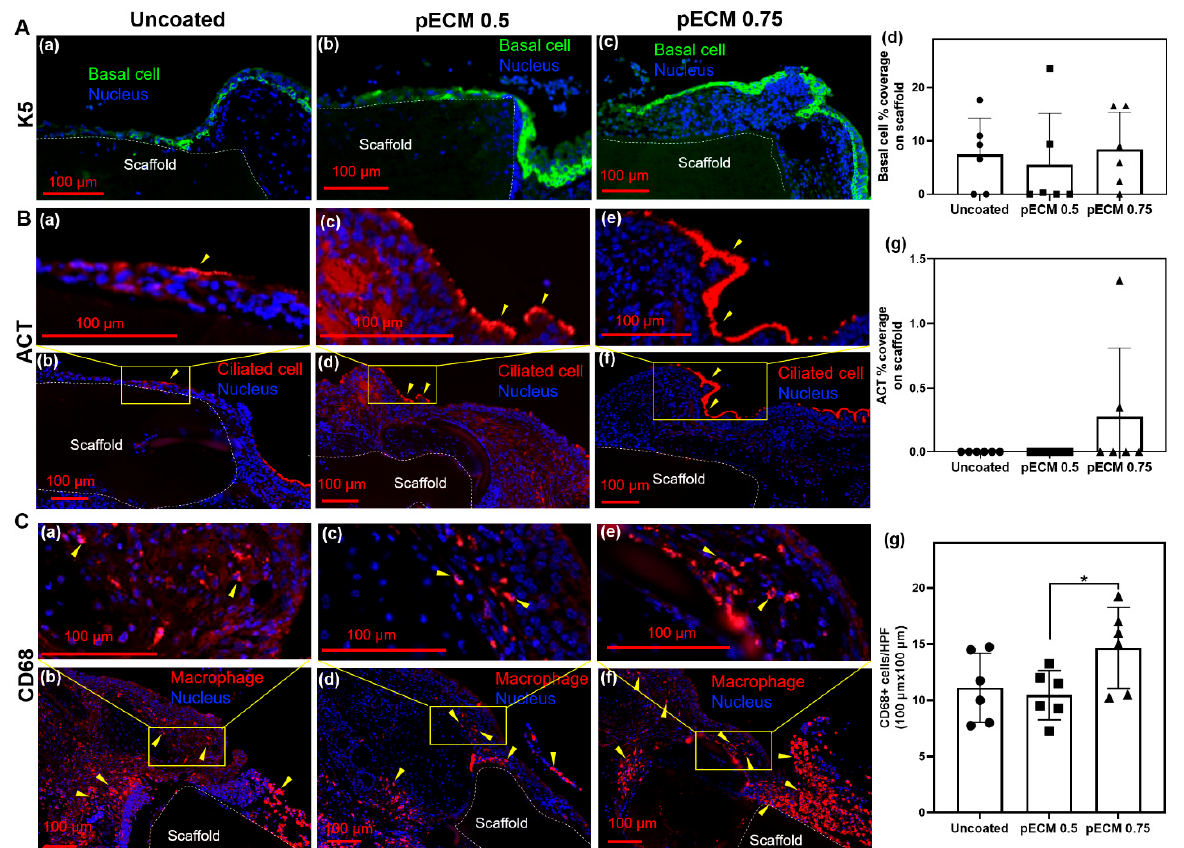
Figure 6. Immunofluorescence characterization of the basal epithelial cell (K5), ciliated epithelial cell (ACT), and macrophage (CD68) on long-segmented syn-TG. ( A ) Representative images (a)~(c) and the quantification (d) of the K5 coverage on the lumen of uncoated and pECM 0.5- or 0.75-mg/mL-coated syn-TG. ( B ) Representative images (a)~(f) and quantification (g) of the ACT coverage on the lumen of uncoated and pECM 0.5- or 0.75-mg/mL-coated syn-TG. ( C ) Representative images of the macrophage infiltration in the tracheal submucosa surrounding syn-TG (a)~(f), and the quantification of the macrophage infiltration (g). * Represents pECM 0.75-mg/mL-coated scaffolds that exhibited higher macrophage infiltrations than pECM 0.5 ( p = 0.0348). No difference was detected between the pECM 0.75-coated scaffold and the uncoated control.